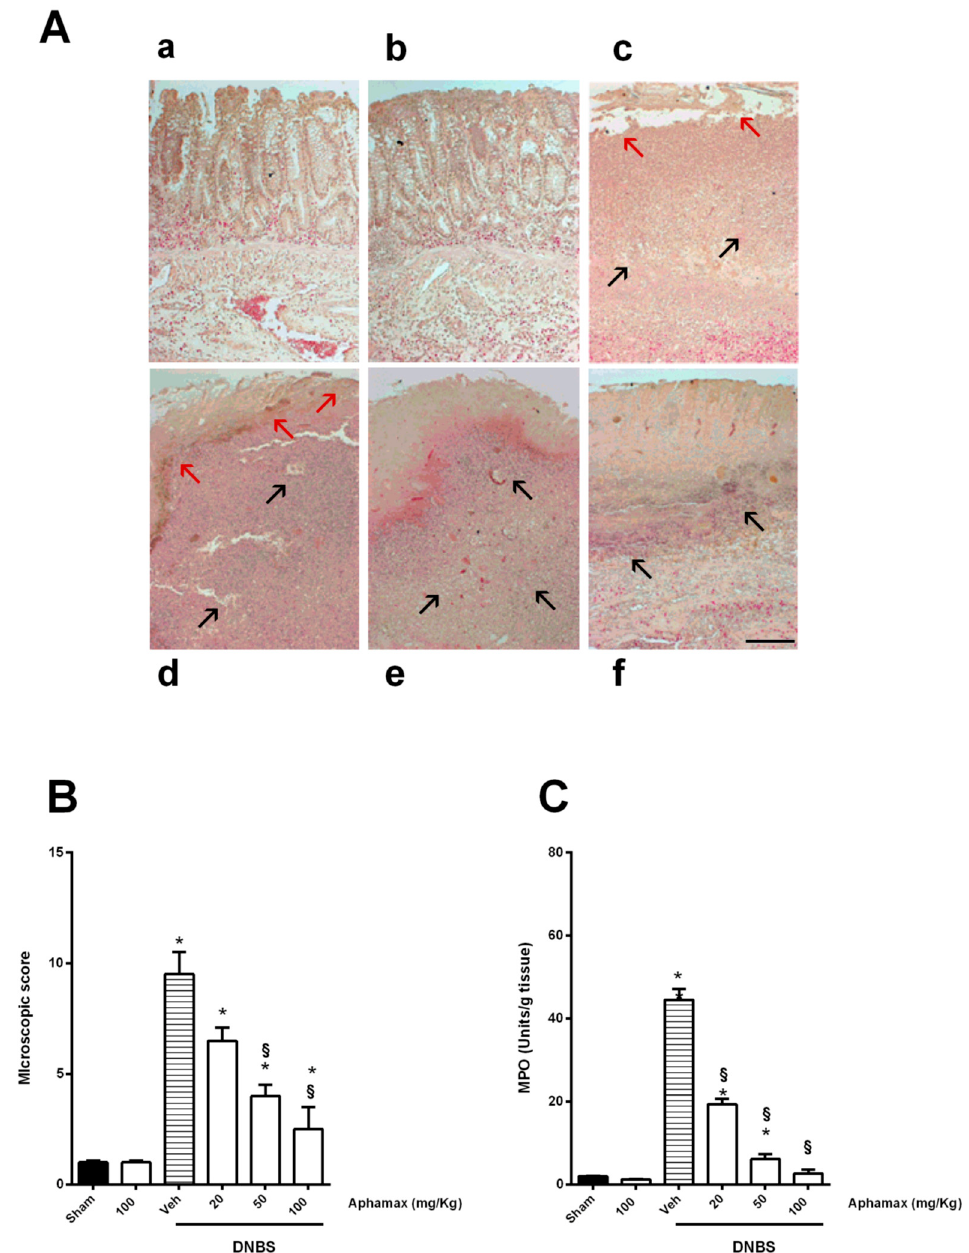
Figure 2. E ff ects of Aphamax ® on DNBS-induced histological damage. ( A ) Photomicrographs of the colon stained with H&E from ( a ) Sham animals, ( b ) Sham rats treated with Aphamax ® (100 mg / kg), ( c ) DNBS animals showing colonic damage and a di ff use infiltration of inflammatory cells in mucosa and submucosa or ( d ) DNBS rats treated with Aphamax ® (20 mg / kg), ( e ) or with Aphamax ® (50 mg / kg), showing progressive reduction of submucosal infiltration of inflammatory cells in submucosal layer and ( f ) DNBS rats treated with Aphamax ® (100 mg / kg) showing few inflammatory cells close to the mucosal layer. (Scale bar = 100 µ m, magnification 20 × , red arrows = colonic damage, black arrows = inflammatory infiltrate)) ( B ) Microscopic damage scored with Hunter method and ( C ) activity of colonic myeloperoxidase in sham rats or Aphamax ® treated rats with or without colitis induction. Data are means ± S.E.M. n = 5 animals for each group. * p < 0.05 versus Sham group; § p < 0.05 versus 2,4 dinitrobenzensulfonic acid (DNBS)